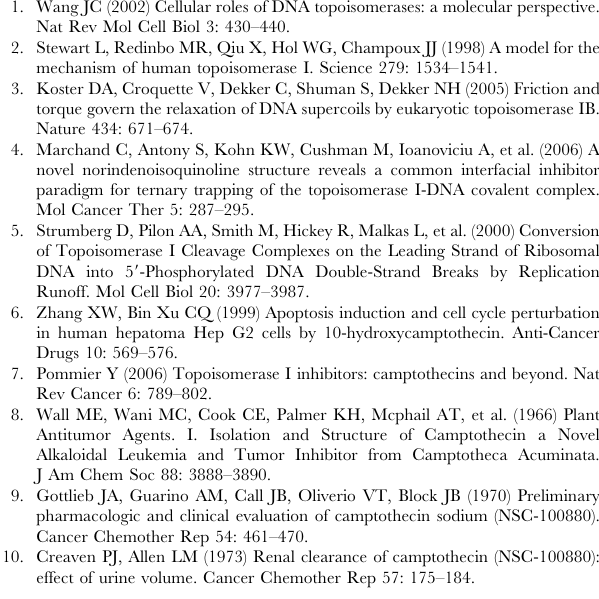
Figure S1 Binding site for the docking simulations. The binding site was defined from the position of the ligand, camptothecin, in the crystal structure ternary complex with a DNA fragment and the top1 enzyme (PDB code 1T8I [23]) and includes both DNA (green) and protein (aqua) residues. Table S1 Training set for ligand-based pharmacophore generation. 2D structures, IC 50 values (in m M) for the inhibition of Top1, and references for molecules used in pharmacophore generation are given. Table S2 Compounds that did not pass the first docking round. Details on the hit list, the rank, the NSC code are given on compounds failing the first round of docking, as well as reasons for